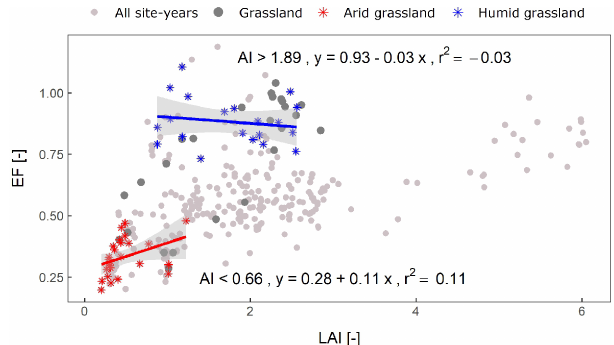
Figure 3. Illustration of the applied methodology. The correlation coefficient between leaf area index (LAI) and evaporative fraction (EF) is calculated for 30 site-years for grassland over a moving win- dow of aridity index. In the illustration, the correlation has a signifi- cant positive slope at p = 0.056 for the 30 most arid grassland sites, whereas the slope is nearly flat and is not significant ( p = 0.49) for the 30 most humid grassland